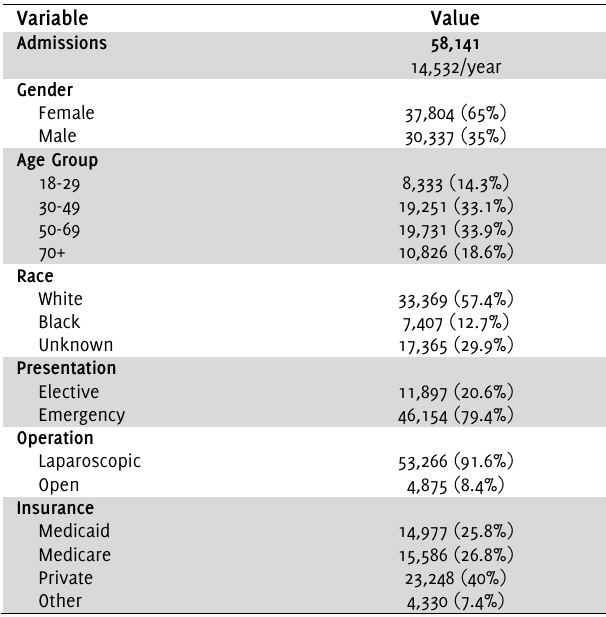
Table 2 . Cholecystectomy Patient Demographic and Clinical Characteristics (2013-2016) Variable